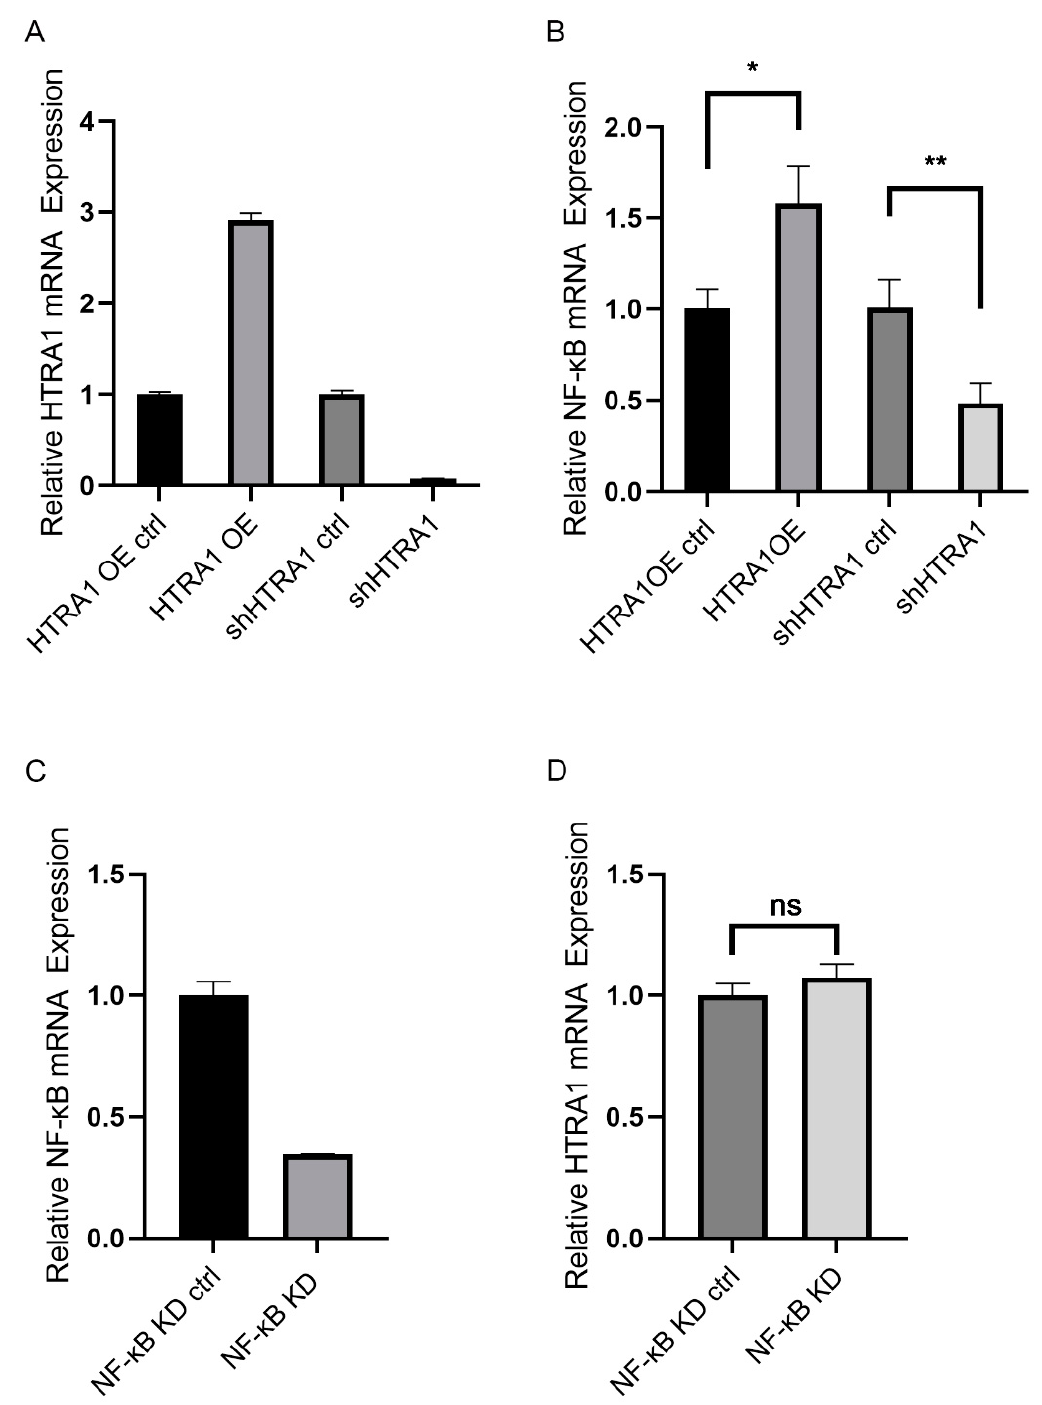
Figure 3. Role of HTRA1 in LPS-induced NF- κ B expression in ARPE-19 cells. ( A ) Verification of efficiency of HTRA1 knockdown and overexpression; ( B ) Relative mRNA level of NF- κ B in HTRA1 knockdown and overexpression cells; ( C ) Verification of efficiency of NF- κ B knockdown; ( D ) Relative mRNA level of HTRA1 in NF- κ B knockdown cells. * p < 0.05, ** p < 0.01, ns = no significance.